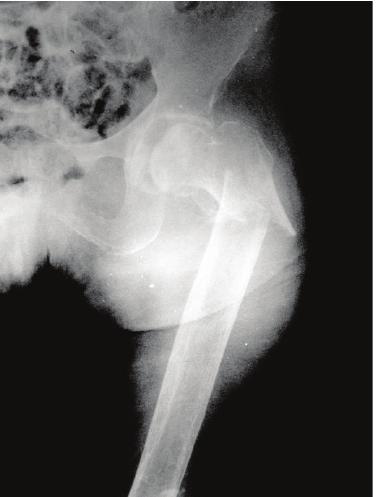
Figure 1: Left intertrochanteric hip fracture seen on radiography. It was understood from the widened femoral canal that osteoporosis was associated with the fracture.